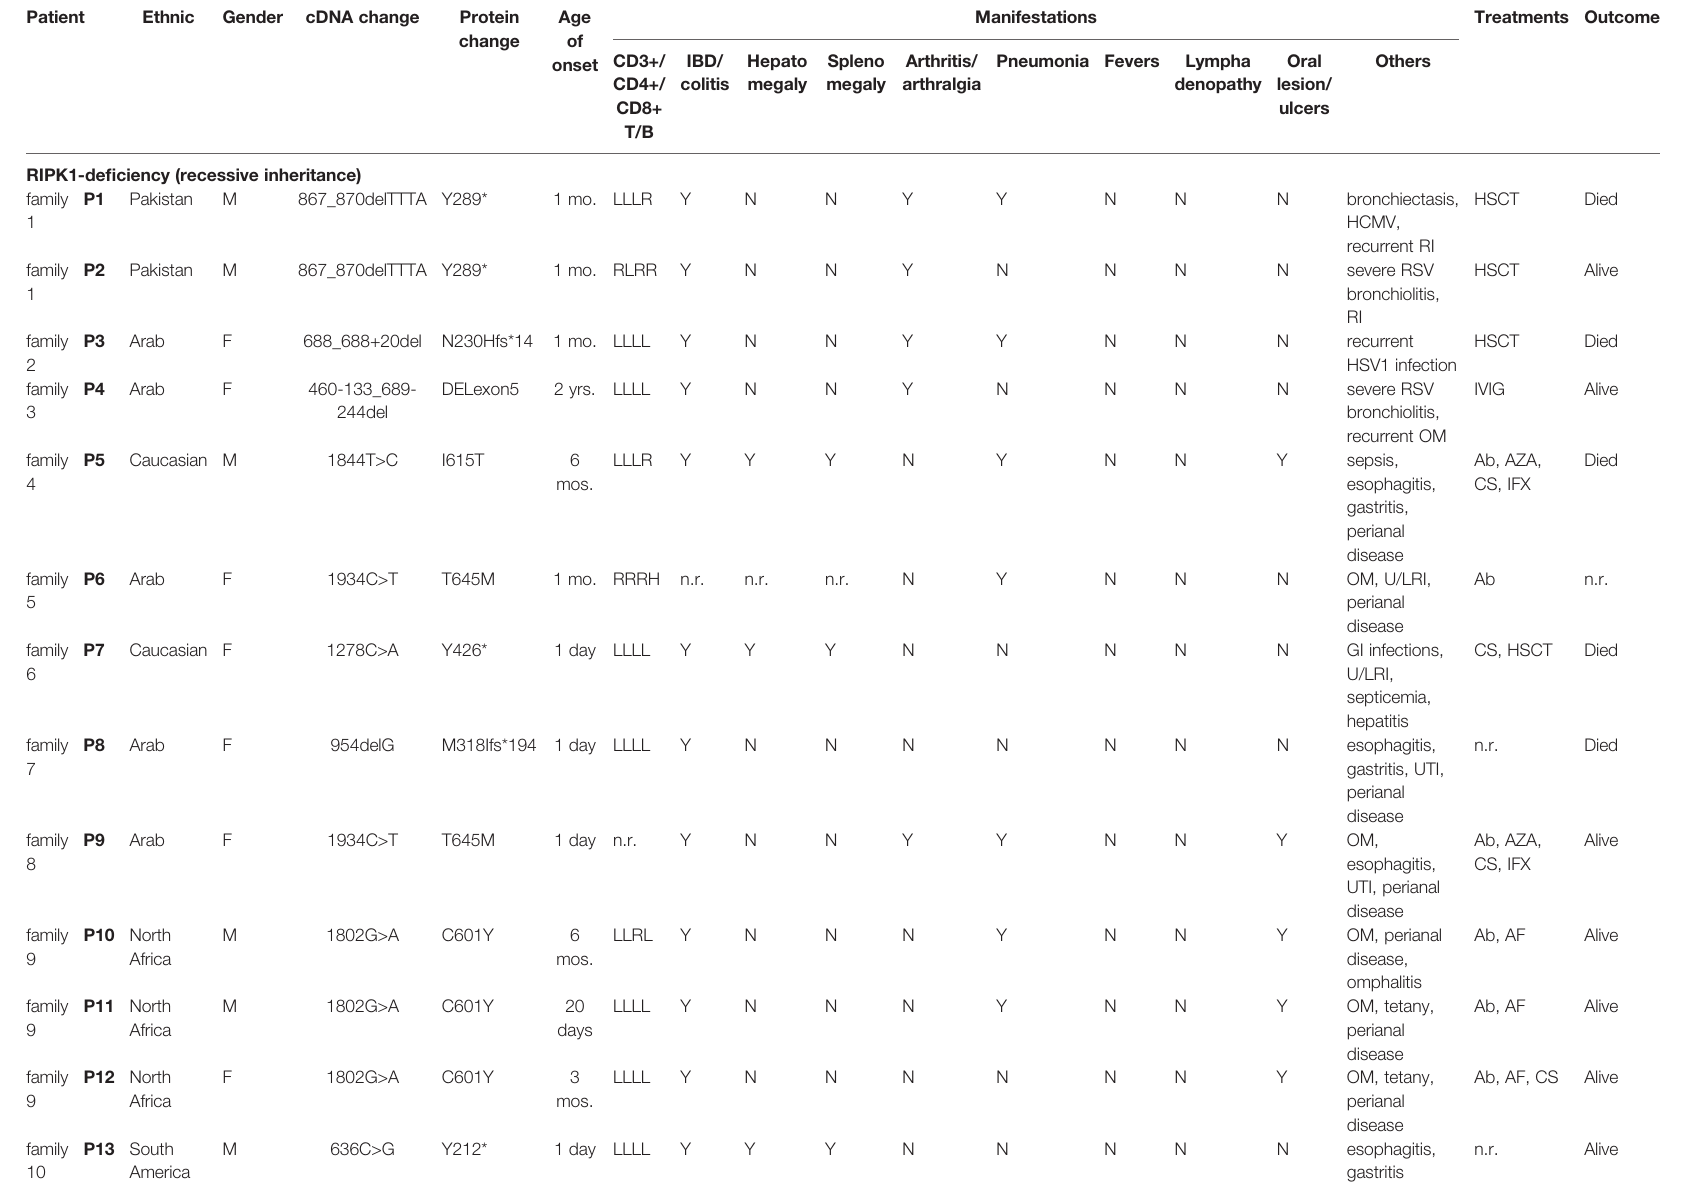
TABLE 1 | Genotypes, clinical phenotypes, immunological manifestations and treatments of RIPK1-de fi ciency and CRIA